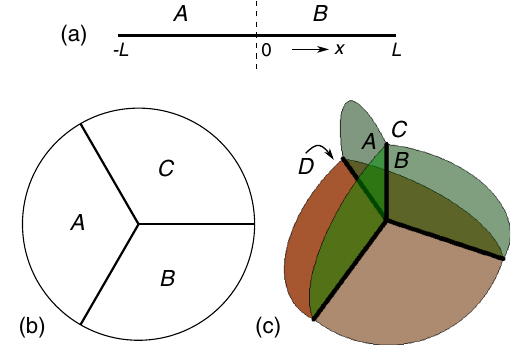
FIG. 1. The D -dimensional Fermi gas for (a) D ¼ 1 , (b) D ¼ 2 , and (c) D ¼ 3 is partitioned into D þ 1 regions that meet at a single point, with any k regions sharing a flat boundary of dimension D þ 1 − k . Here we study an entanglement measure, known as the mutual information, that captures the intrinsic correlations among all D þ 1 regions. The mutual information is topological in that it exhibits a leading logarithmic divergence proportional to the Euler characteristic χ of the Fermi F